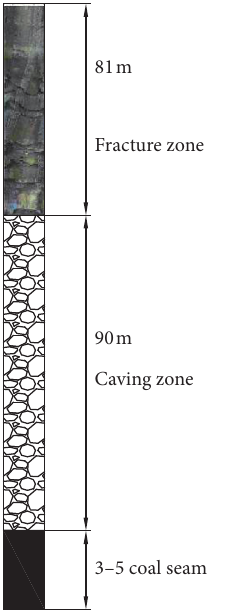
Figure 7: Caved and fractured zone